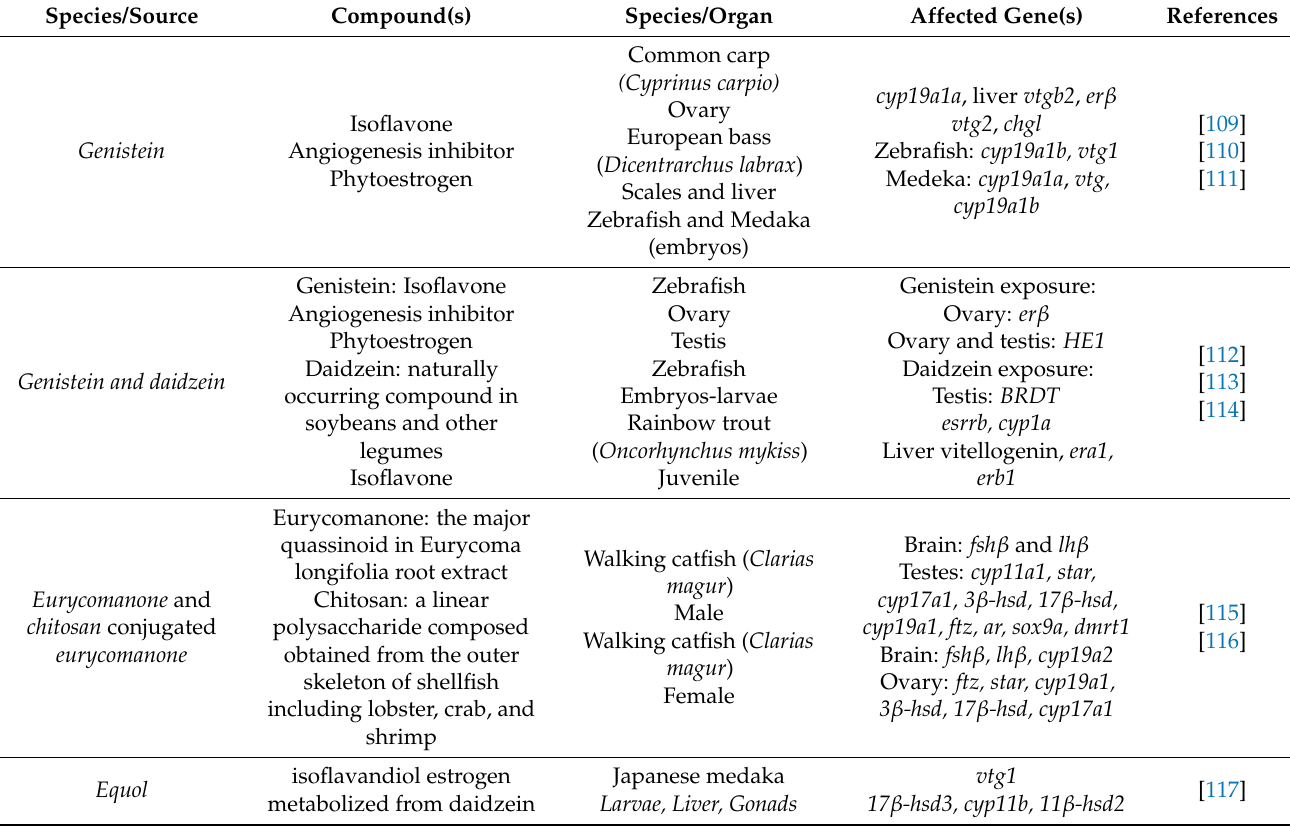
Table 3. The effect of herbal extracts and phytochemicals on reproduction-related genes. Species/Source Compound(s) Species/Organ Affected